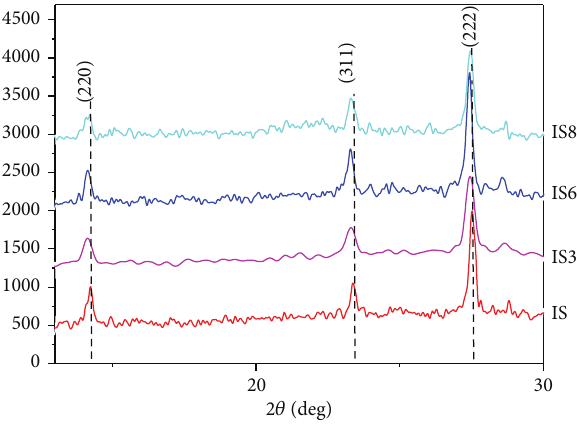
Table 2: Average grain size of the Ag-doped In different dopant levels.